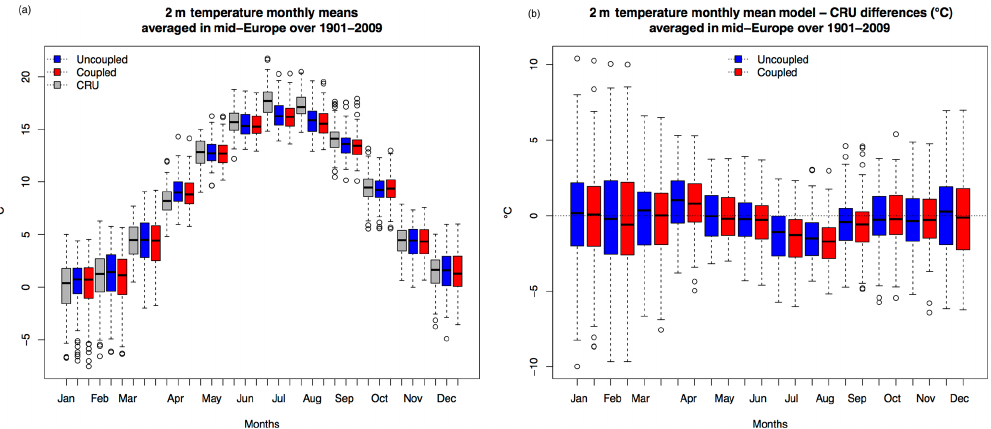
Figure 12. Box plots showing the annual cycle during the 20th century of the 2m air temperature monthly means averaged over mid-Europe for the CRU observations (grey), the uncoupled system (blue), and the coupled system (red) (a) , as well as the annual cycle of the model errors compared to CRU observations over mid-Europe (b) .